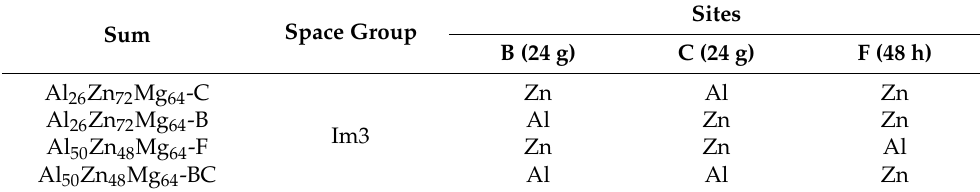
Table 1. The model structure of T